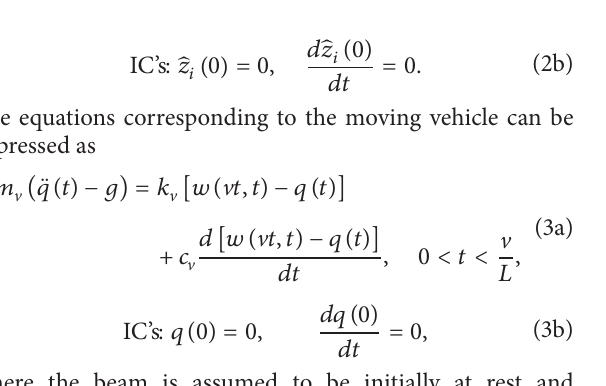
Figure 1: A Simply-supported beam attached to 𝑁 -absorbers and subjected to a moving vehicle with a constant